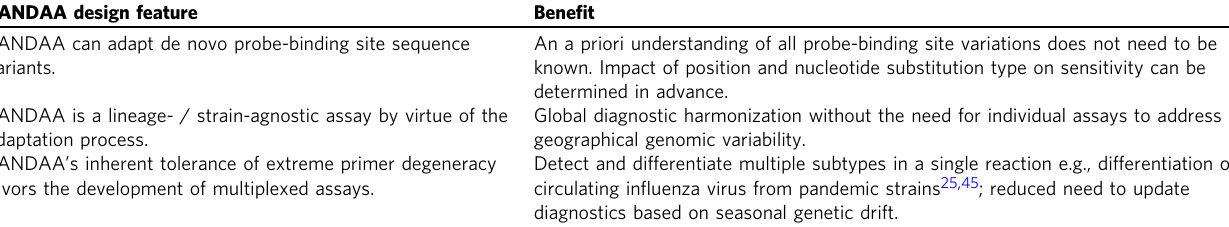
Table 5 Strengthening of diagnostics for epidemic prevention and containment using